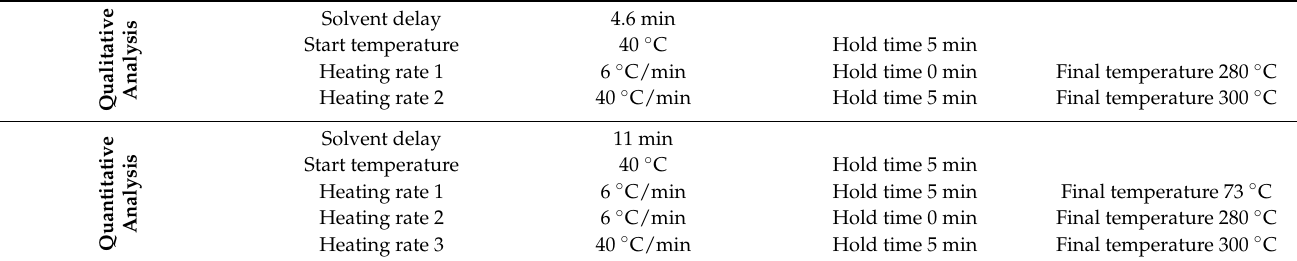
Table 5. Temperature programs for the GC